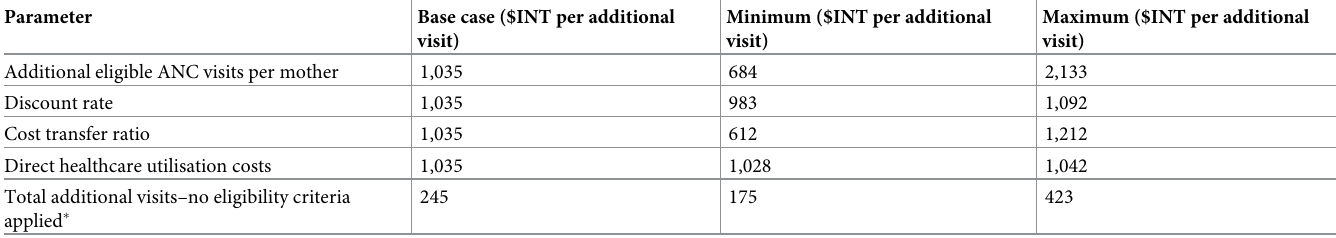
Table 5. Sensitivity analysis results.